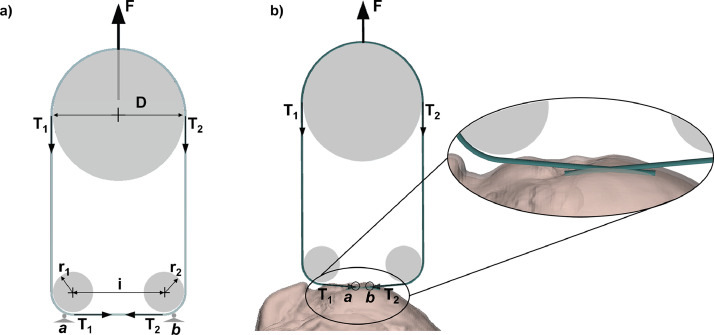
(a) Static equilibrium of forces for the loading set up here introduced; (b) the path of the wire on a sutured organ.